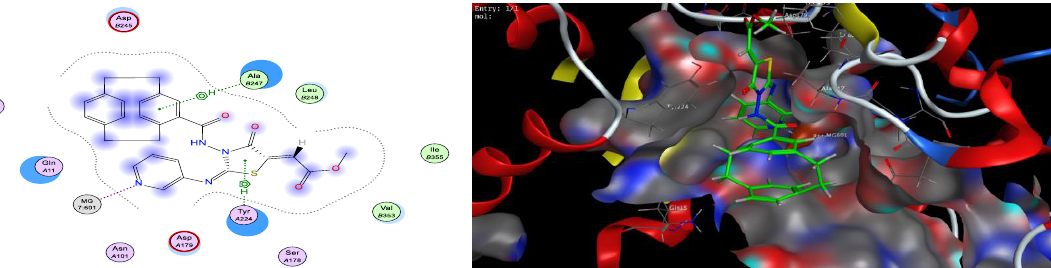
Figure 18. The 2D and 3D diagrams illustrate the binding mode of 3c interacting with the colchicine binding site of β-tubulin.